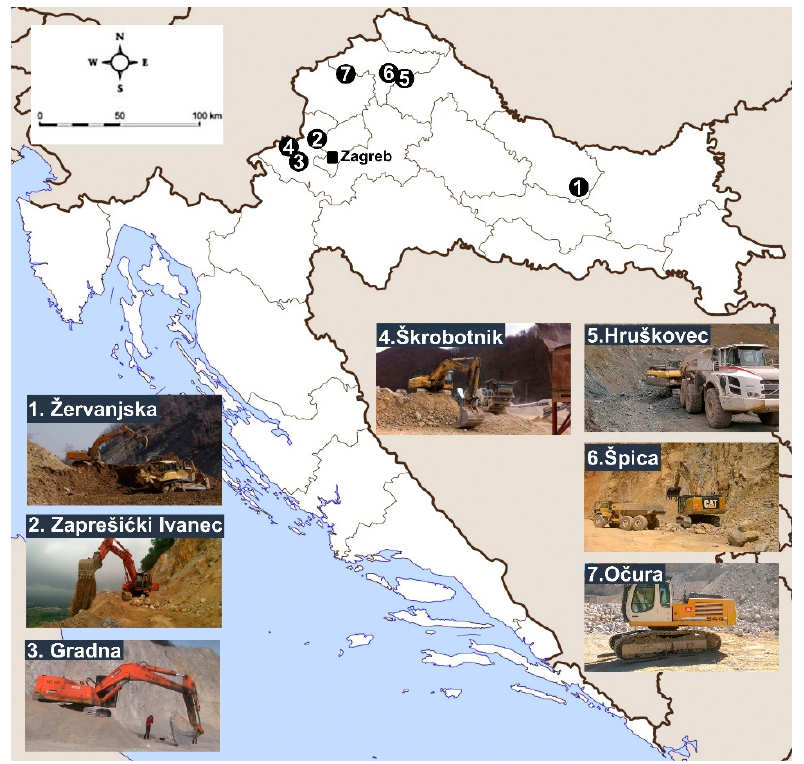
Figure 1. Locations of quarries where field measurements were conducted.